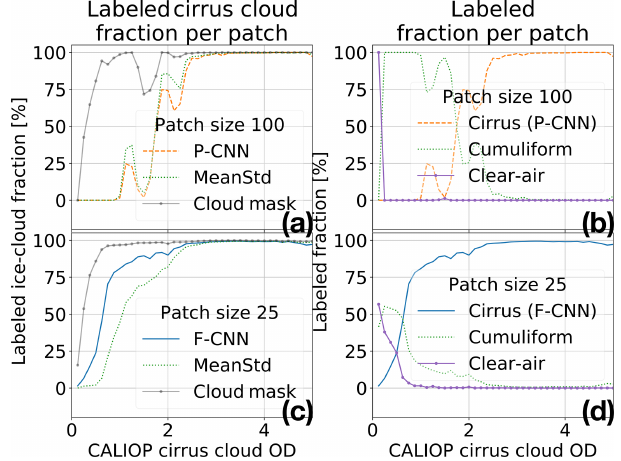
Figure 11. For the patches that intersect with the CALIPSO satellite track and the CALIOP cloud product indicating that only ice was present, panels (a) to (d) show the fraction of cirrus/high-altitude clouds detected versus cloud optical depth (OD) in the intersec- tion by the different methods of the proposed methodology and the MODIS cloud mask (CM). Panels (a) , (b) and (c) , (d) show the fraction of cirrus/high-altitude clouds detected for methods operat- ing on 100- and 25-pixel patches, respectively. Panels (b) and (d) show what the patch intersections were labeled as, versus optical depth, by the pretrained convolutional neural network ( P-CNN ) and fine-tuned CNN ( F-CNN ) methods. The MODIS cloud mask in pan- els (a) and (c) provides a benchmark for detecting clouds.